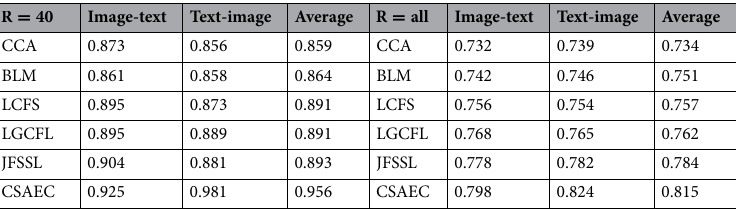
Table 4. MAP results of different methods